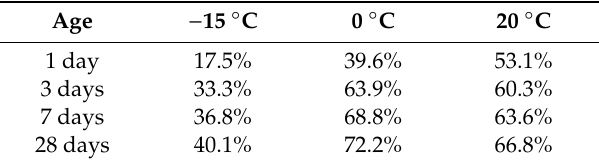
Figure 2. XRD patterns of samples at different temperatures: ( a ) −15 °C; ( b ) 0 °C ; and ( c ) 20 °C . Table 1. Calculated hydration degree of C 4 A 3 S̅ cured at different temperatures.